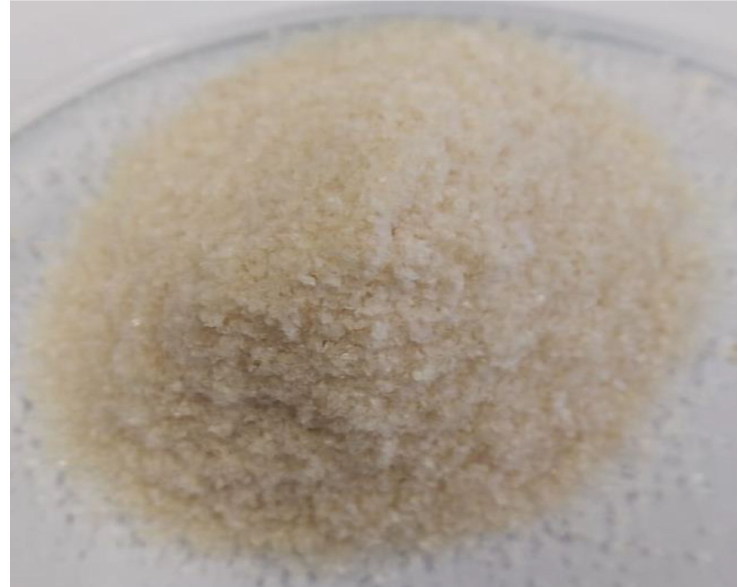
Figure 2. Chitosan from dry carapace of M. rosenbergii